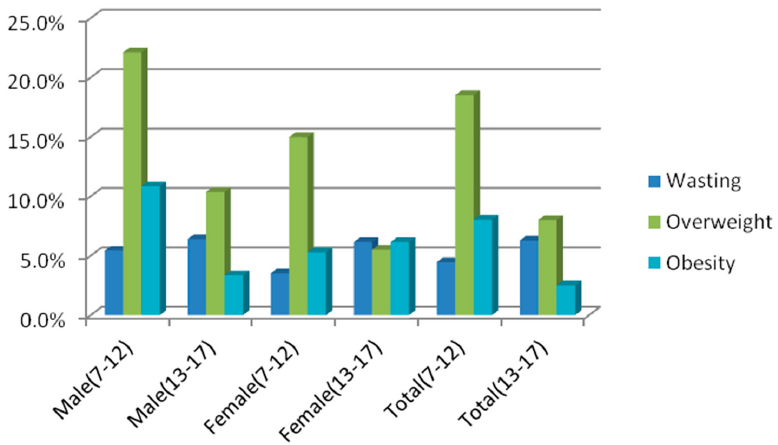
Figure 2. The percentages of population from wasting to obese.